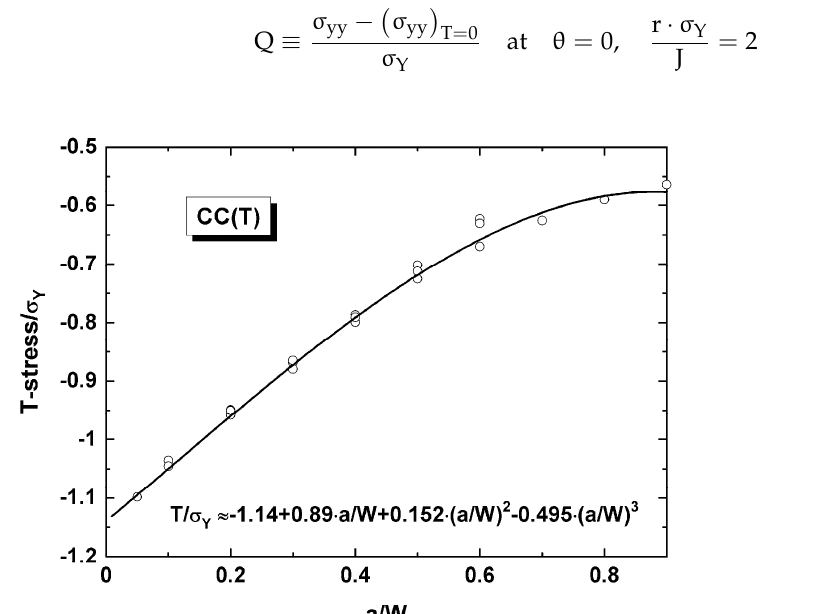
Figure 4. T-stress at limit load, normalized by yield strength, for a CC(T) specimen, as a function of relative crack length a/W [5].